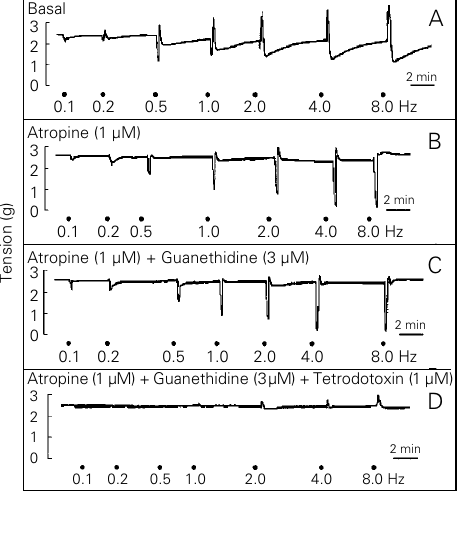
Figure 2 - Representative trac- ings showing the response of isolated pyloric strips to differ- ent EFS frequencies (0.5 ms, 40 V for 10 s) in the absence (A) or in the presence of atropine (B), atropine + guanethidine (C) or atropine + guanethidine + tetro- dotoxin (D). The strips were in- cubated with the drugs for at least 20